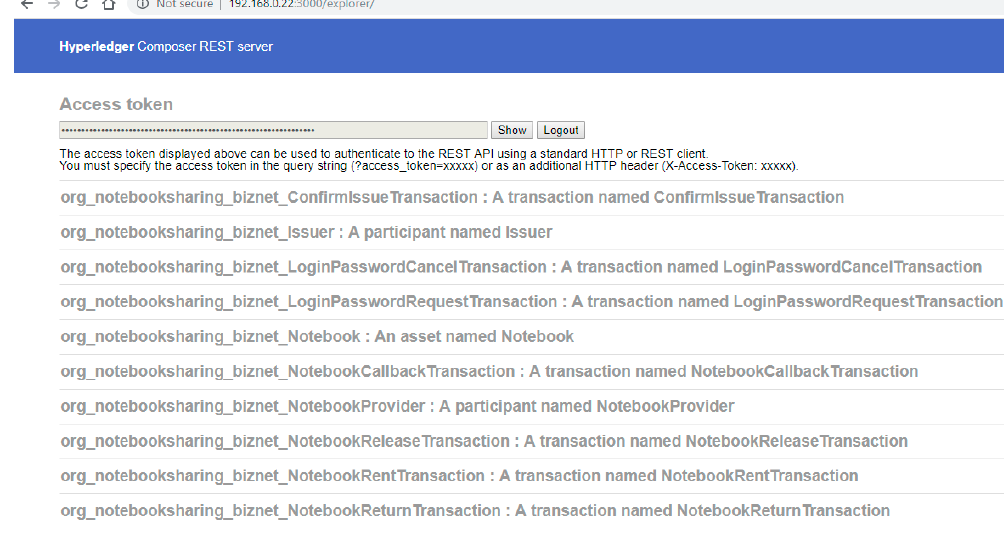
Figure 14. Composer web playground main interface.